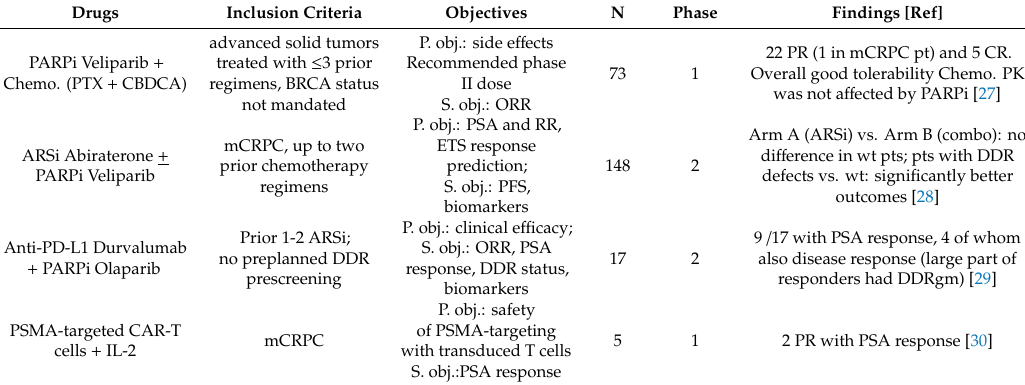
Table 2. Prospective clinical studies with combined drug therapies in mCRPC patients. Drugs Inclusion Criteria Objectives N Phase Findings [Ref] advanced solid tumors PARPi Veliparib + treated with ≤ 3 prior Chemo. (PTX + CBDCA) regimens, BRCA status not